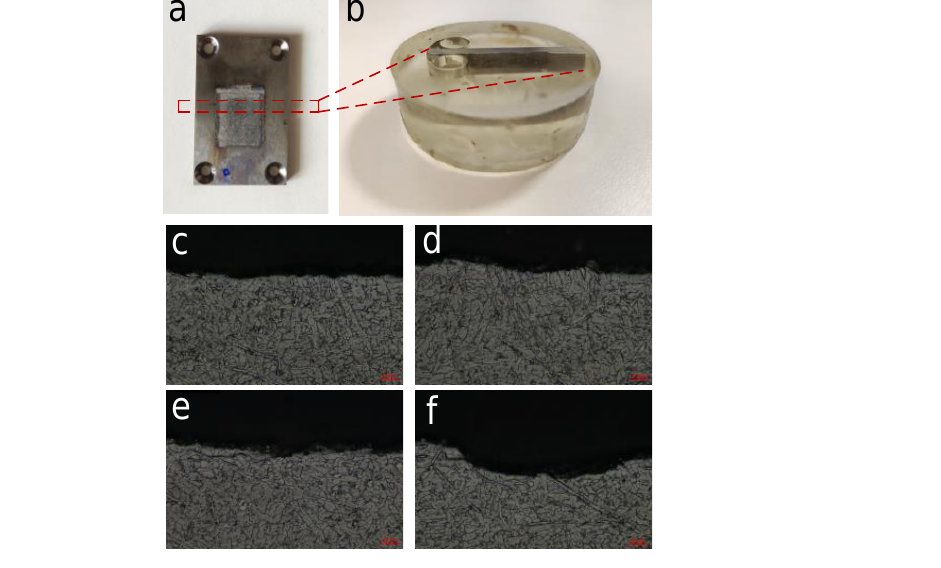
Figure 8. ( a ) Sample after single-groove milling experiment. The red dotted frame is cut by low-speed wire cutting, embedded in acrylic, ( b ) The re-polished sample. ( c – f ) Metallographic images after ECM processing.